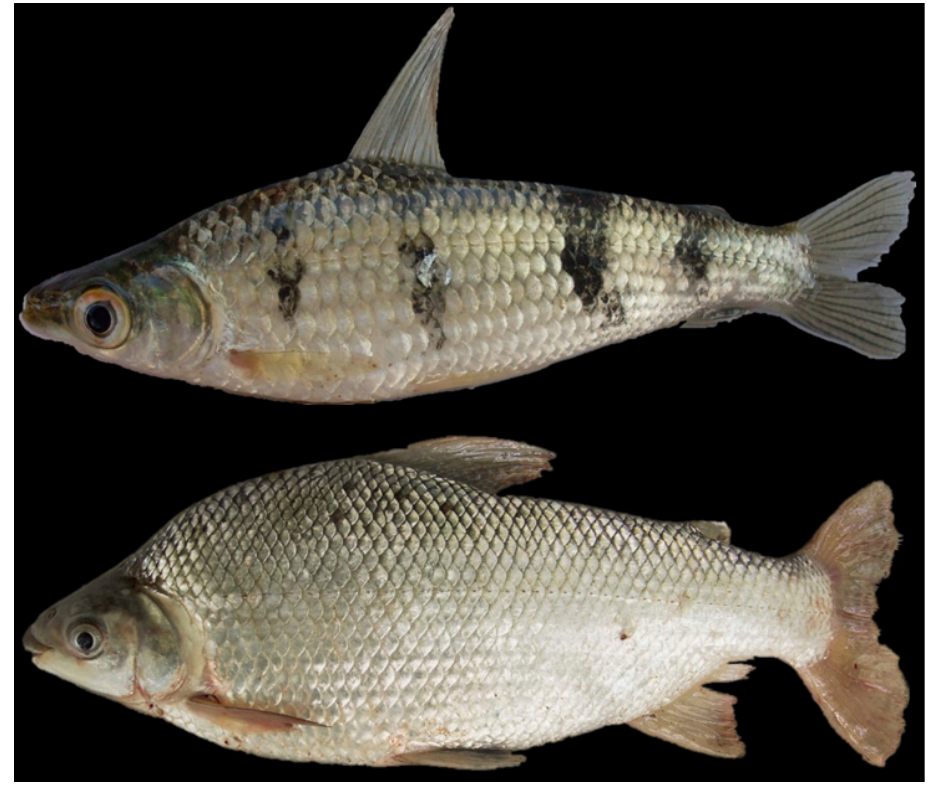
FIGURE 1 | Species used in this study, Schizodon dissimilis (above) and Prochilodus lacustris